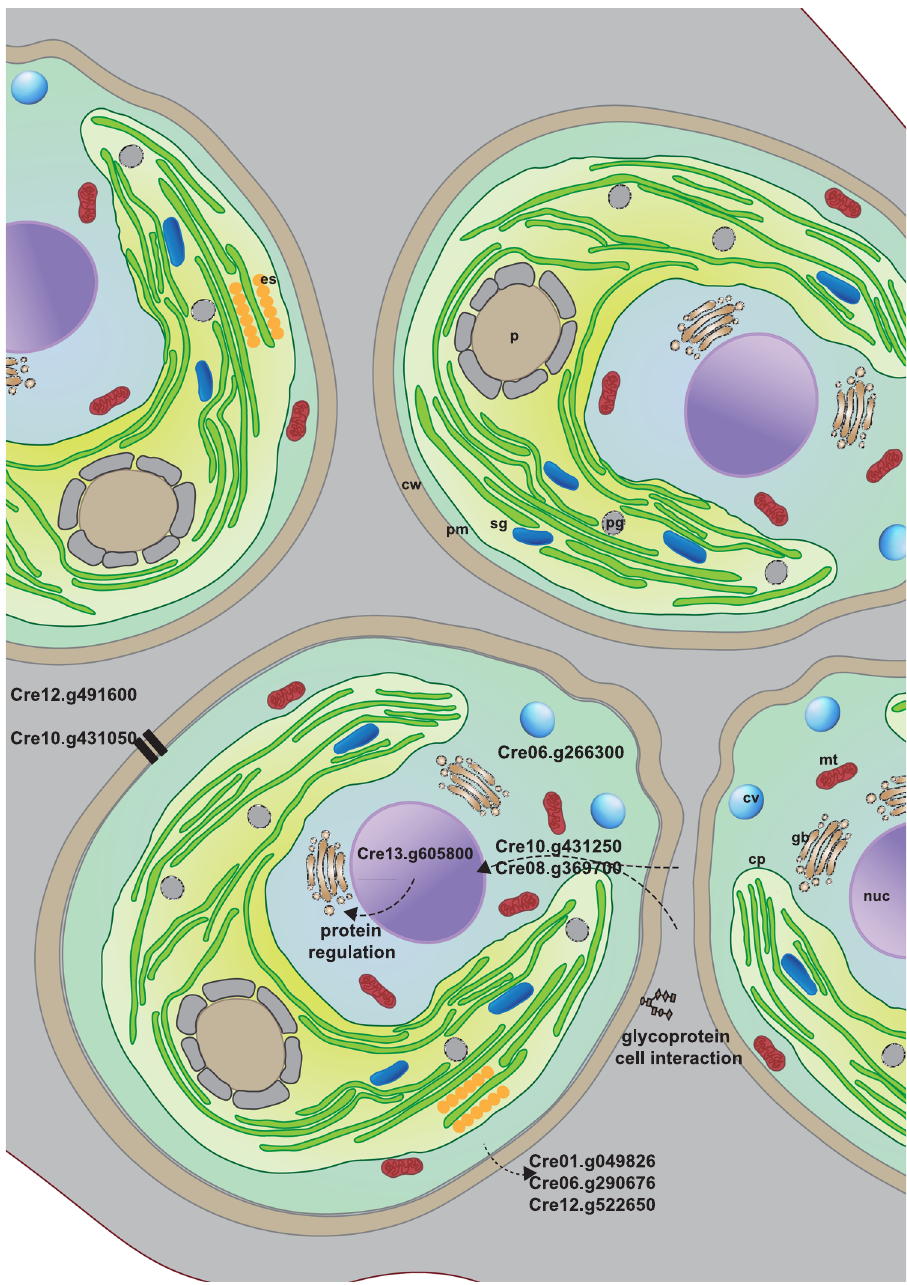
Fig. 3 Graphical model of genomic changes in cell clusters. Cells of cell cluster are embedded in an extracellular matrix (gray), which keeps cells together after cell divisions. Processes that are affected by genomic changes observed only in cell clusters are described for the cell at the bottom left. Cell organelles are indicated in the other cells: cw: cell wall, pm: plasma membrane, sg: starch granule, p: pyrenoid, mt: mitochondria, cv: contractile vacuole, cp: chloroplast, gb: golgi body, nuc: nucleus, es: eyespot. to the selection fl asks. The rotifer stock culture is derived from an isolate from Milwaukee harbor, Wisconsin 54 and maintained on Monoraphidium minutum . We (hereafter clones). As some colonies did not grow in liquid after isolation for grew the cultures for six months, replacing ~50% of the culture with fresh medium unknown reasons, the number of clones further analyzed differed between strains every 7 – 10 days without controlling rotifer and algae densities. Cultures were kept and selection treatment, with 8 – 12 clones per strain and selection treatment. at 25°C in indirect, constant light and static conditions. The number of generations Morphology was determined after growing the clones for 3 days in liquid medium was estimated using a doubling time of 0.4 days (~9h) and the number of days of (160 μ M of nitrogen) under the microscope. Clones were classi fi ed into six different the selection experiment. This calculation is based on optimal growth conditions as morphotypes: non-motile single cells, some motile single cells, majority motile exact conditions in the selection experiments are not known (changes in nutrient single cells, cell clusters with no single cells, cell clusters with non-motile single cells concentrations over time due to consumption by the algal cells and bacteria, as well and cell clusters with motile single cells. Cells were considered motile when they as recycling of nutrients through rotifer and bacterial excretion). were actively swimming during microscopic observations. In addition, growth rates of evolved clones and the corresponding rotifer growth rates were measured Isolation, growth rate, and morphotype classi fi cation . At the end of the separately. Algal clones were grown with a fi xed rotifer population for 3 days in liquid medium (160 μ M of nitrogen) and their OD (at a wavelength of 600 nm, experiment, we plated algae on COOL800 ANC 2% agar plates (800 μ M nitrogen NATURE COMMUNICATIONS| (2021) 12:4222 |https://doi.org/10.1038/s41467-021-24503-z|www.nature.com/naturecommunications